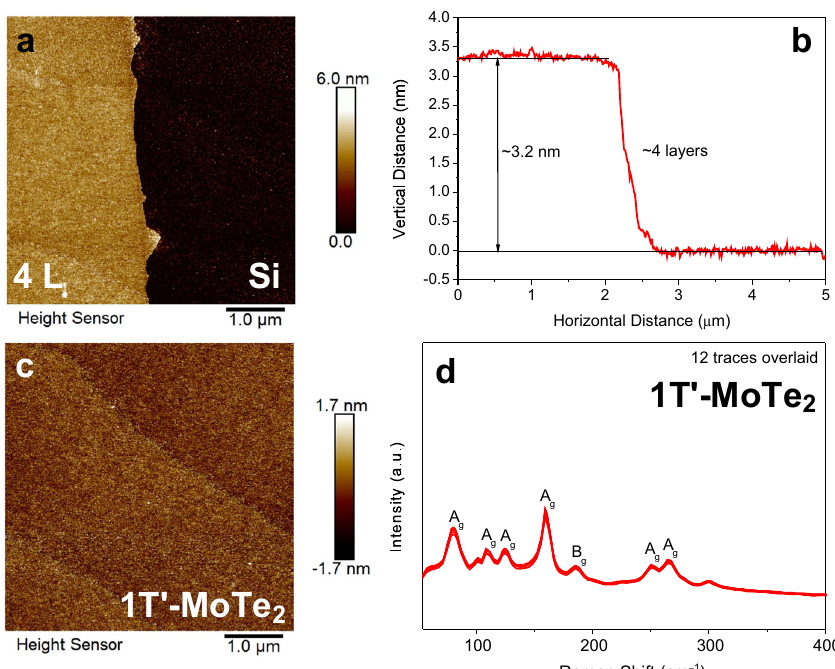
Fig. 4 Surface characterisation of 1T ′ -MoTe 2 fi lms. AFM measurement over the 5 μ m × 5 μ m area and a representative 2D topographic pro fi le of the interface between few-layered 1T ′ -MoTe 2 and SiO 2 /Si substrate ( a ); the variation in height between the fi lm and the substrate measured on a 4-layered 1T ′ -MoTe 2 fi lm from Fig. 4a ( b ); 2D topographic pro fi le of a 5 μ m × 5 μ m area of 4-layered MoTe 2 on SiO 2 /Si substrate ( c ); 532 nm Raman spectrum from a typical four-layered 1T ′ -MoTe 2 on 300 nm SiO 2 /Si ( d